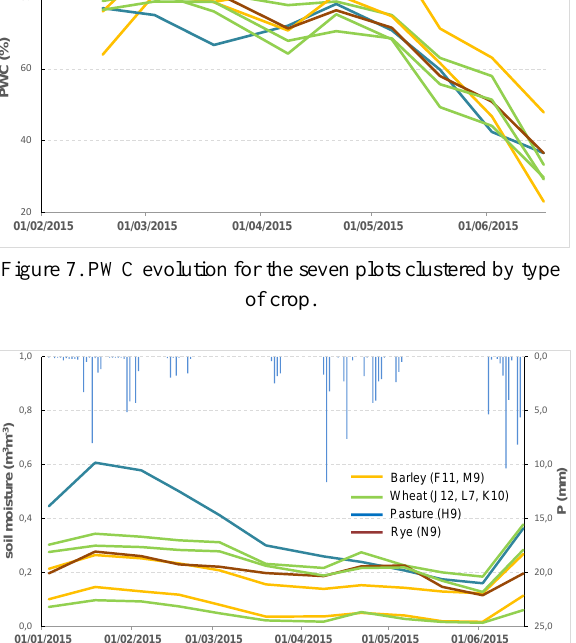
Figure 8. Soil moisture evolution for the seven plots clustered by type of crop. Precipitation data is also shown.